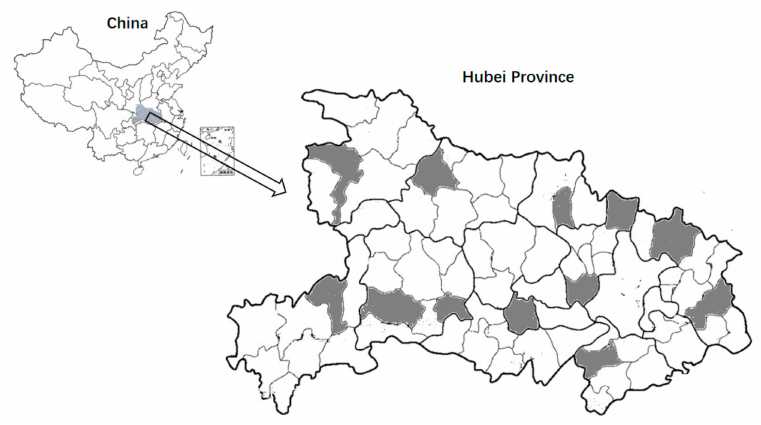
Figure 1. Distribution map of the sample